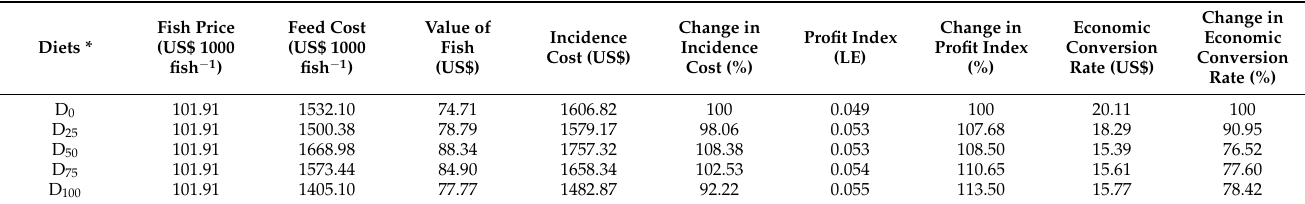
Table 8. Cost-profit analysis of Mugil cephalus fed on experimental